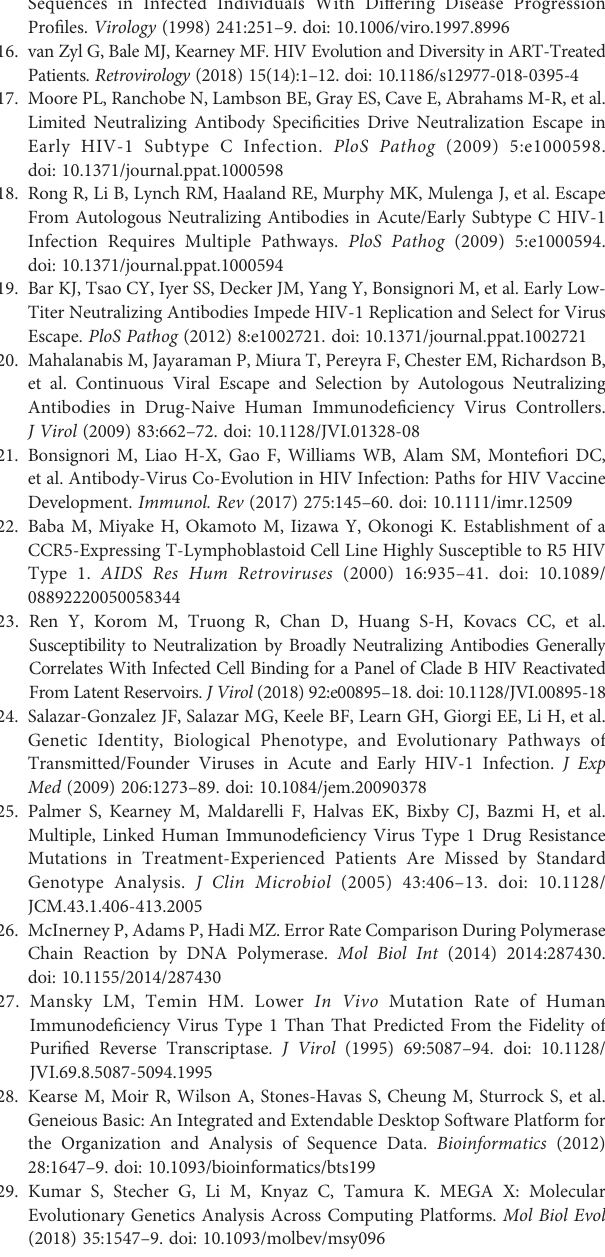
Supplementary Figure 1 | Single genome ampli fi cation sequences obtained from each individual. Maximum likelihood trees of all SGS sequences obtained for each individual. (A) Trees of individuals with low diversity (<2% predicted APD). Scale bars are 0.001 for these individuals, with the exception of OM5365 (grey), where the scale bar is 0.0002. (B) Trees for individuals with high diversity (>2% predicted APD). Scale bars are 0.01 for these